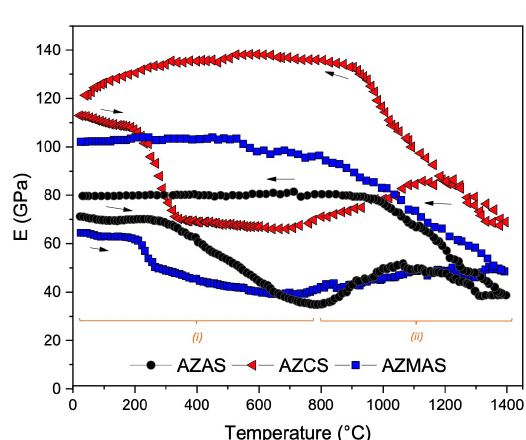
Figure 1. Curing behavior of the castables as a function of time at room temperature (~ 23 °C). AZA, AZMA and AZC results were previously presented by Pinto et al. 16 .